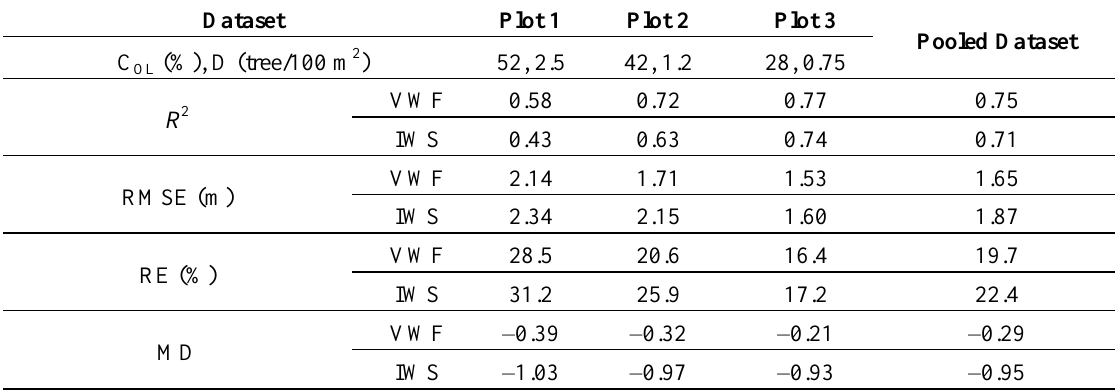
Table 7. Performances of the VWF and IWS methods in estimating crown diameter from LiDAR data. Dataset Plot 1